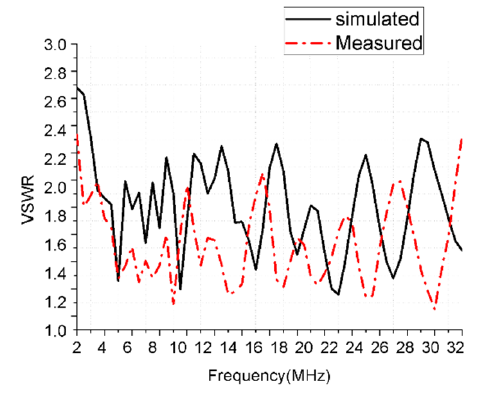
Figure 11. Tested VSWR and simulated VSWR.